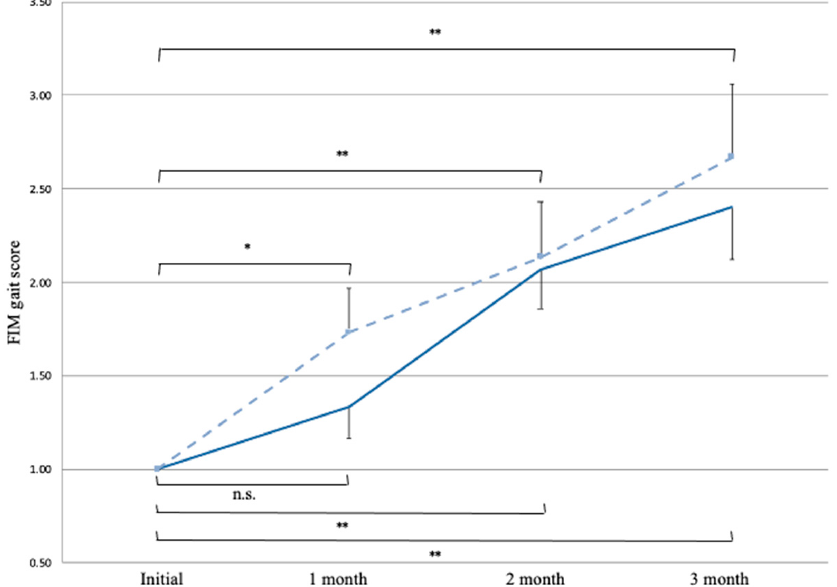
Figure 3. Multiple comparison using Bonferroni correction with covariance of “time from stroke to admission”. There was a significant increase in the FIM gait score from the initial measurement to the measurement at 1, 2, and 3 months in the AGT subjects; however, in the HC subjects, a significant increase was observed at 2 and 3 months. The dotted line indicates the AGT group, and the straight line indicates the HC group. Each point represents the mean. The vertical bars indicate standard errors. *, p < 0.05; **, p < 0.01; n.s., not significant; FIM, functional independence measure; AGT, alternate gait training; HC, historical control.